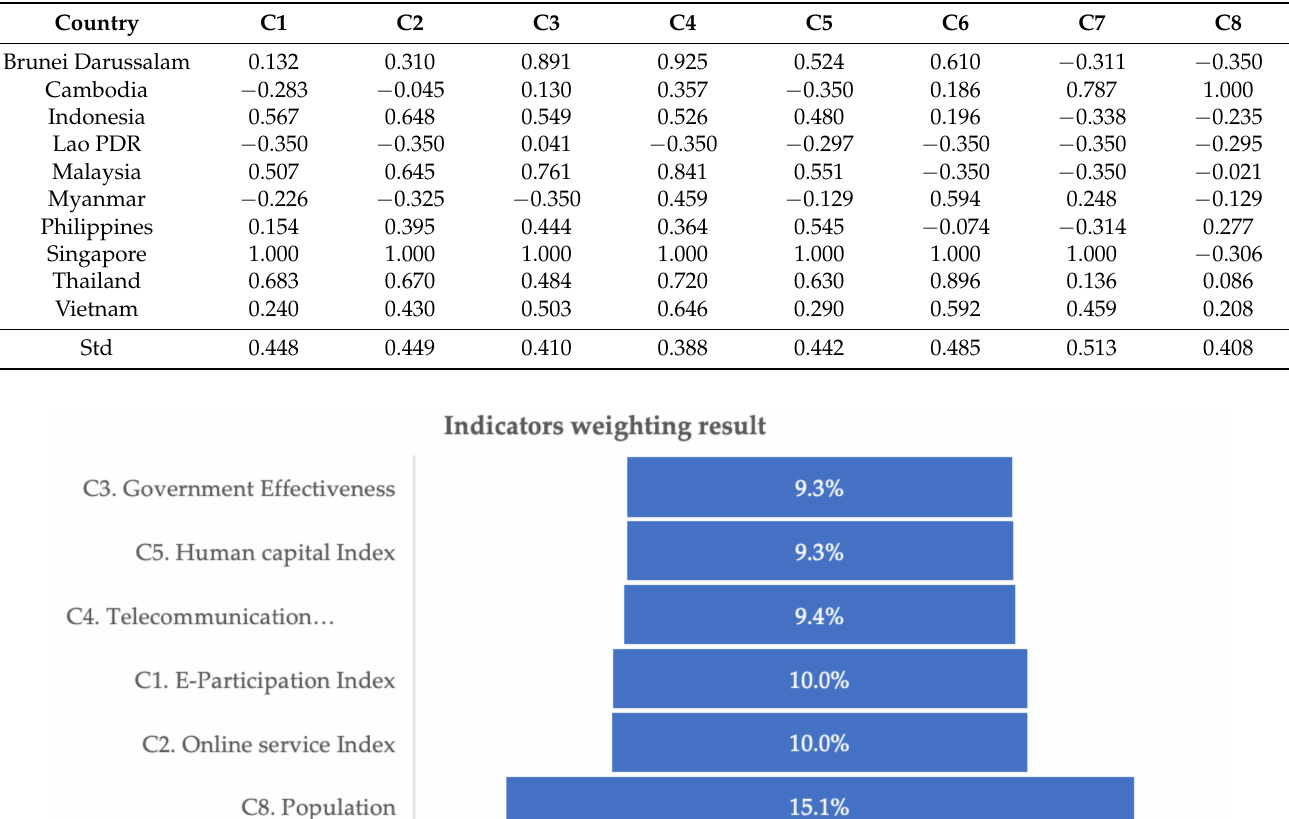
Table 6. Final utility matrix.